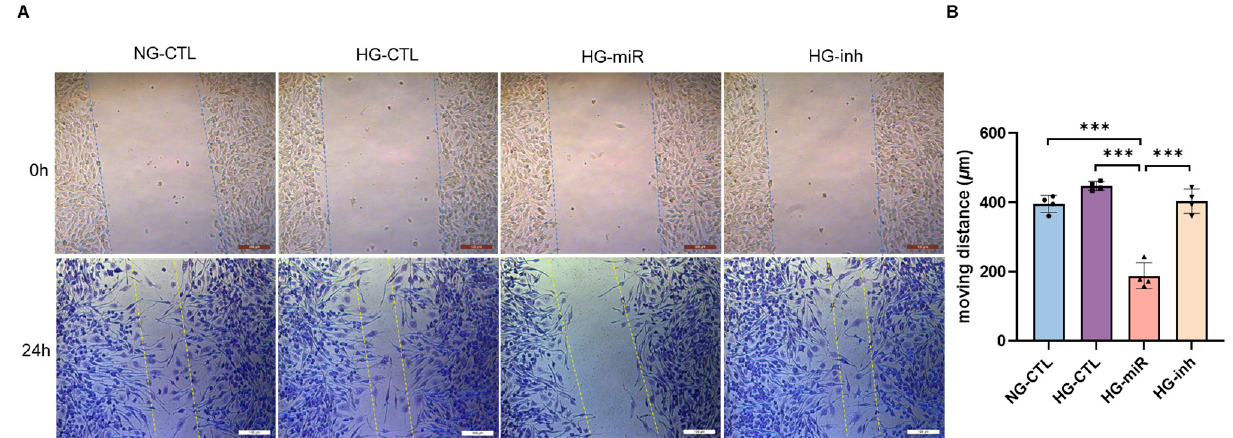
Figure 6. Effect of miR-124 on microglia mobility in high glucose conditions. ( A ) Representative images of WHA performed with high glucose (4.5 g/L)-treated BV2 cells which were transfected with control miRNA (HG-CTL), or miR-124 mimic (HG-miR) or miR-124 inhibitor (HG-inh) for 24 h. Cells cultured in normal glucose medium and transfected with control miRNA were used as control (NG-CTL). At the endpoint, cells were fixed in methanol and stained with Giemsa. The images at the time point of 0 h (upper panel) and 24 h (low panel) were taken with the Leica DMIRB light microscope, scale bar = 200 µ m. ( B ) Quantification of the moving distances calculated from the gap sizes measured at 0 h and 24 h, 10 random measurements of each image, 4 images from each group. Data are shown as mean ± SD, n = 4, *** p < 0.001 (one-way ANOVA with Tukey’s multiple comparisons test).